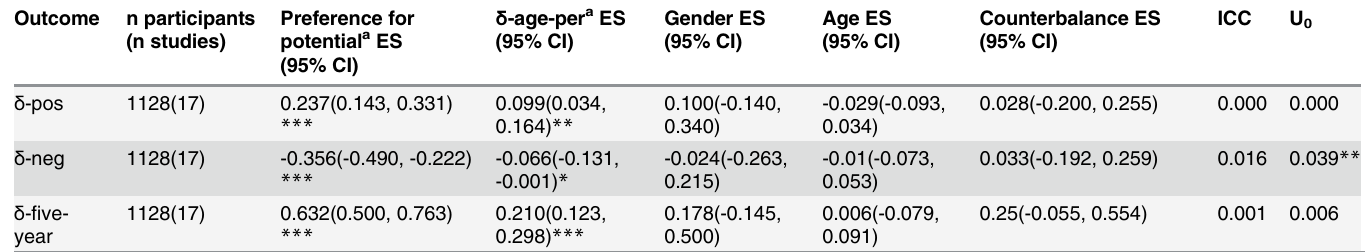
Table 4. The effect of pro-youth bias on preference for potential.